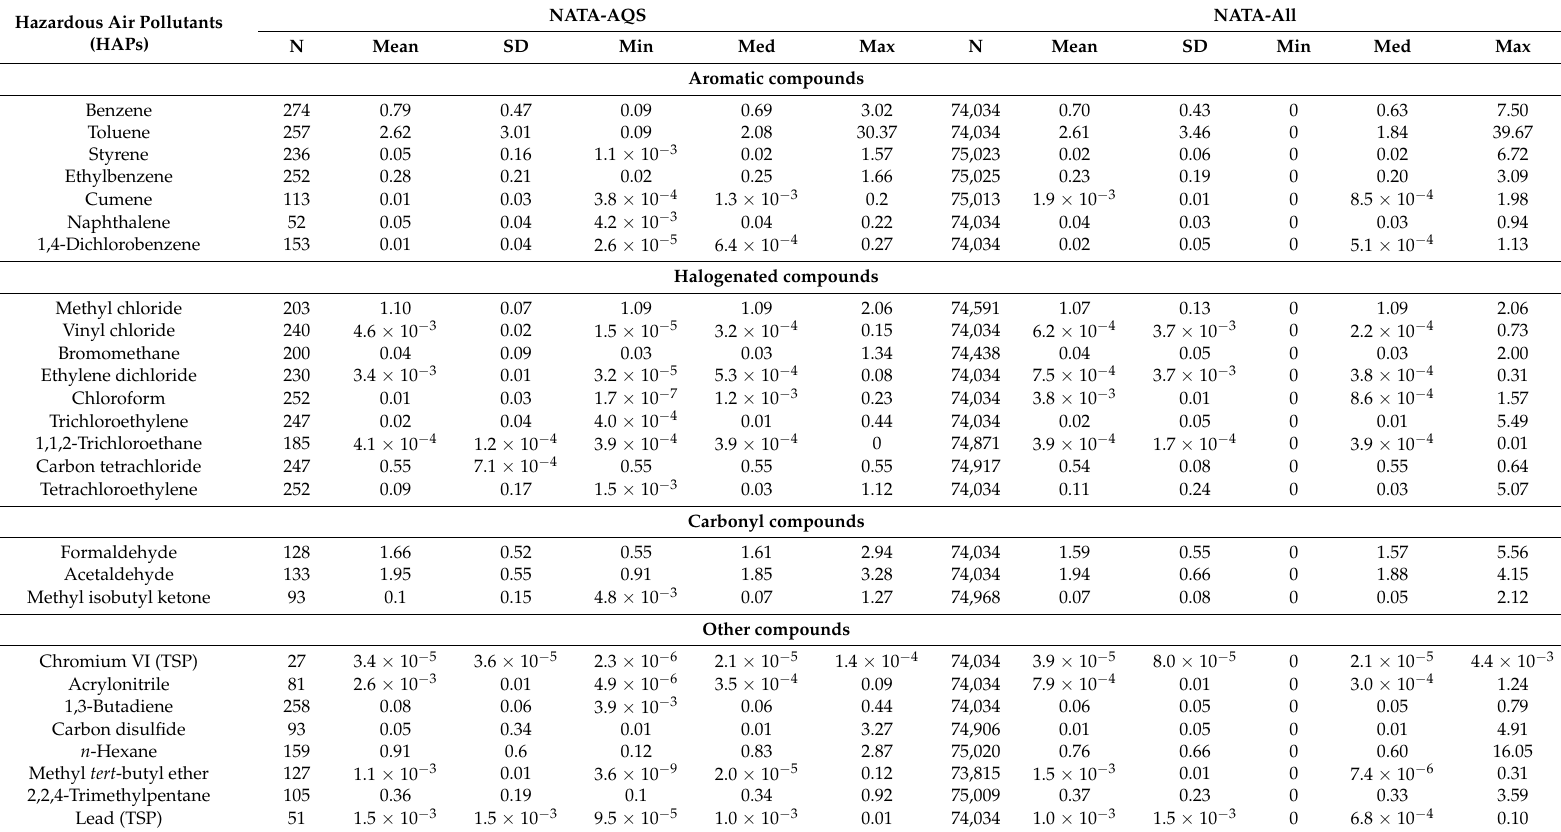
Table 1. Descriptive statistics of annual average concentrations ( µ g/m 3 ) in NATA-AQS and NATA-All